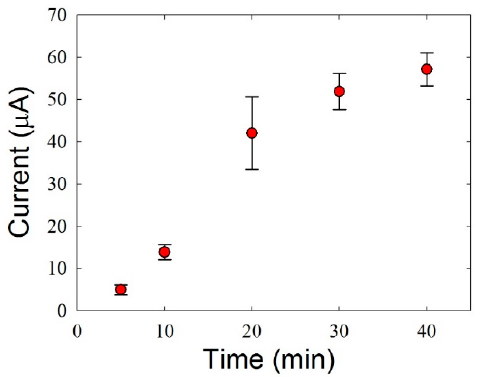
Figure 5. Oxidation currents according to the duration of the submersion of ITO electrodes in 1 mM DA. The error bars indicate the standard deviations of at least three measurements.